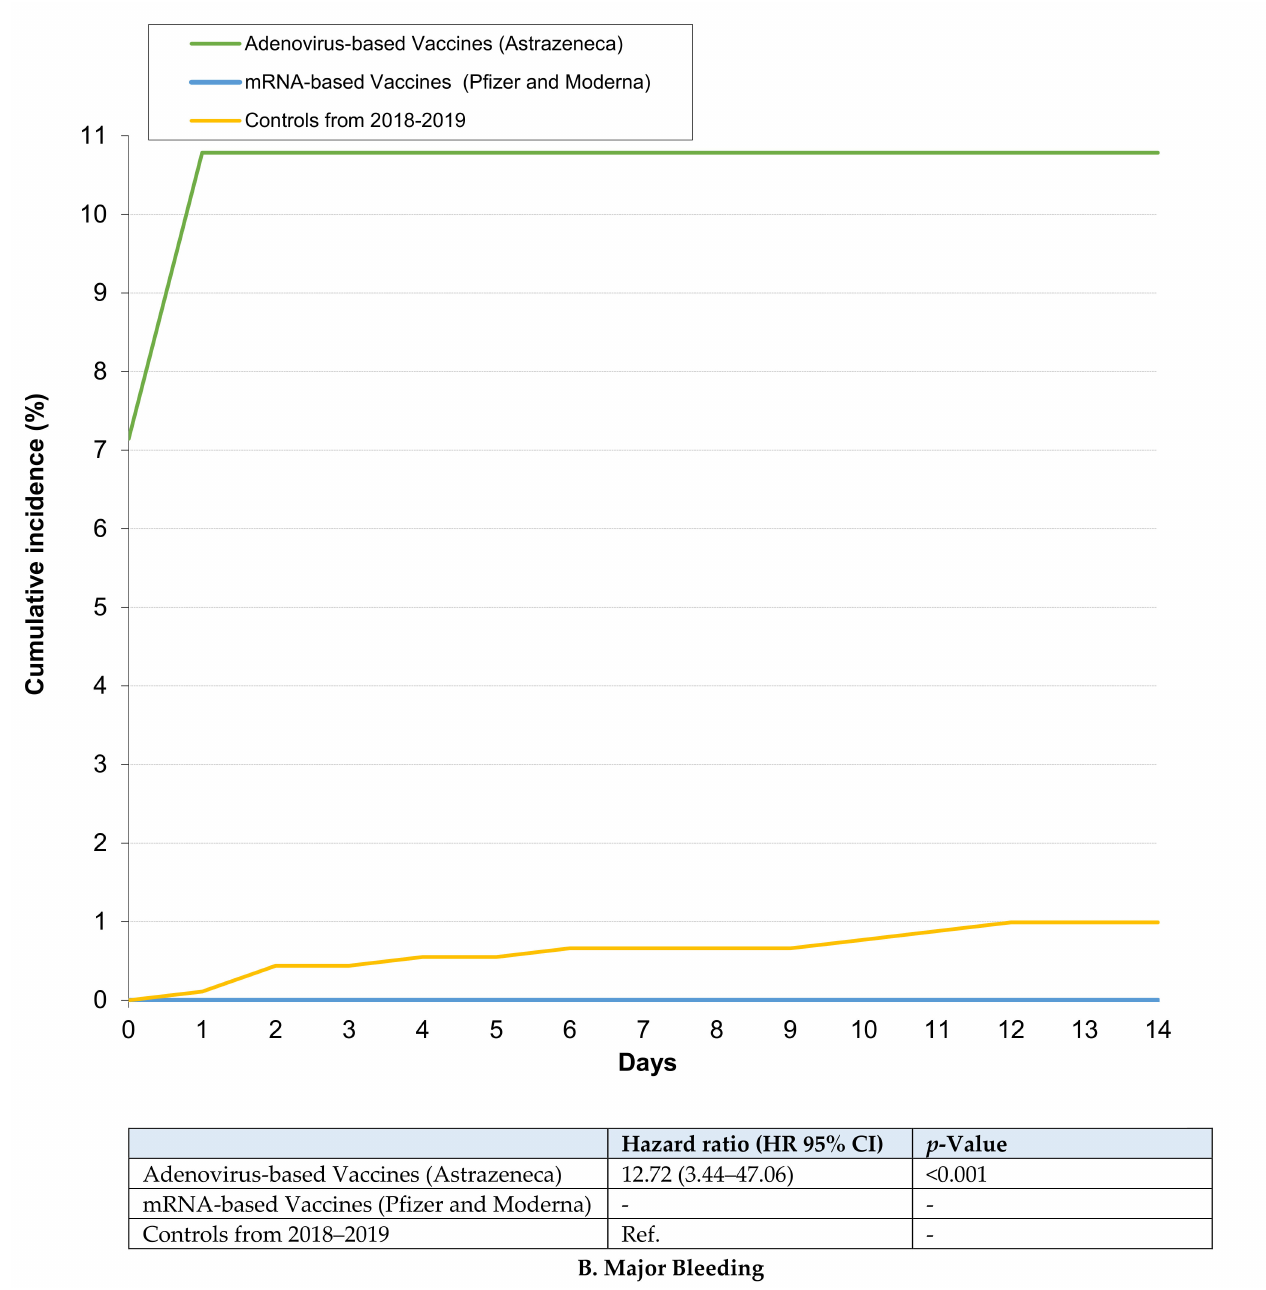
Figure 3. Cumulative incidences for all-cause mortality ( A ) and major bleeding ( B ) in patients with Post-SARS-CoV-2 vaccination VTE compared with patients with VTE in 2018 and 2019. – means not